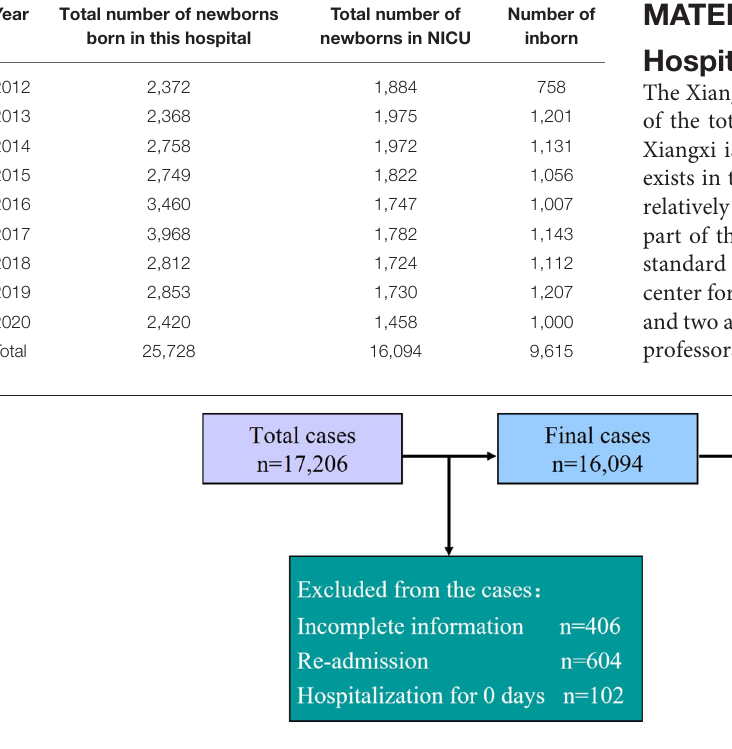
FIGURE 1 | Overview of the study